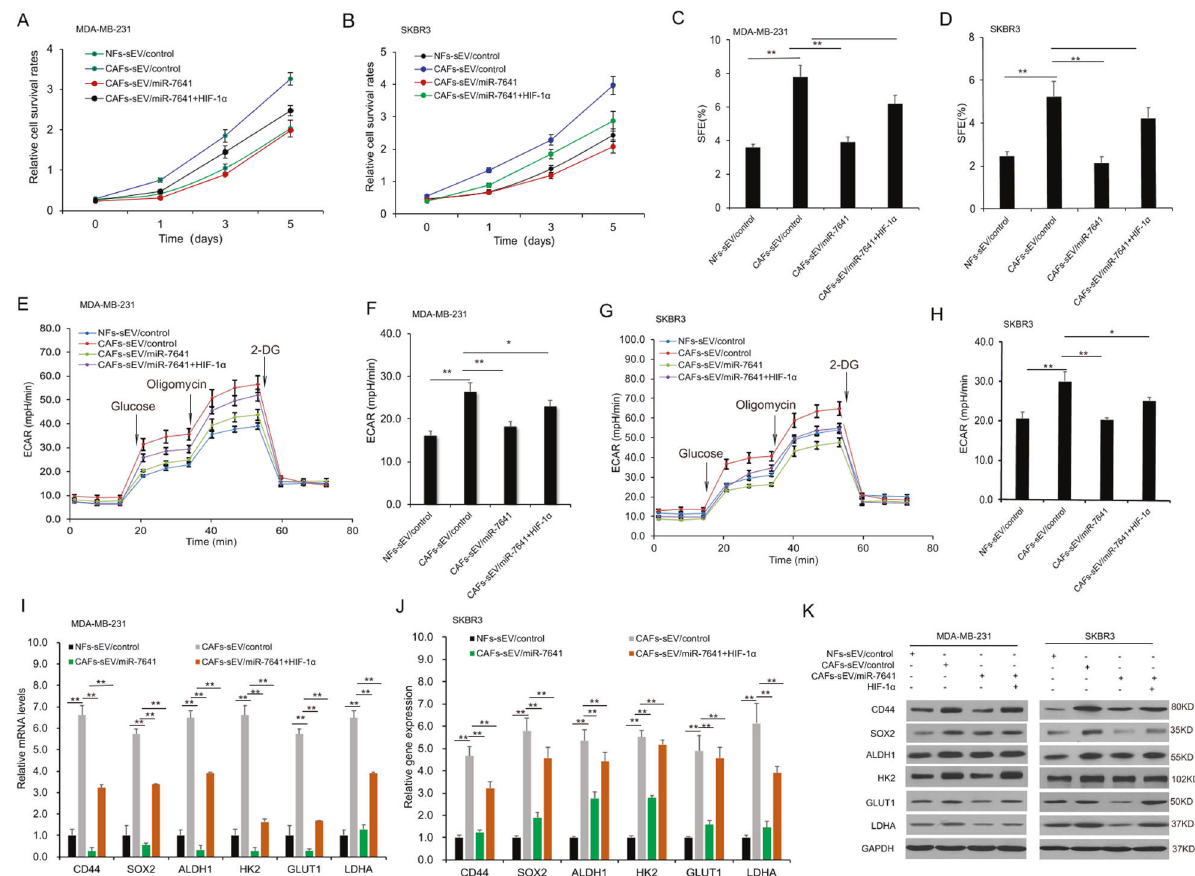
assayed by the CCK8 kit. C , D Sphere formation analysis of spheres in SKBR3 and MDA-MB-231 cells. Cells were overexpressed HIF-1 α and cultured with sEVs from NFs, CAFs, or CAFs with miR-7641 overexpression. The photos were taken under a microscope. E , F ECAR in MDA-MB- 231 cells. Cells were overexpressed HIF-1 α and cultured with sEVs from NFs, CAFs, or CAFs with miR-7641 overexpression, and ECAR was analyzed using seahorse. G , H ECAR in SKBR3 cells. Cells were overexpressed HIF-1 α and cultured with sEVs from NFs, CAFs, or CAFs with